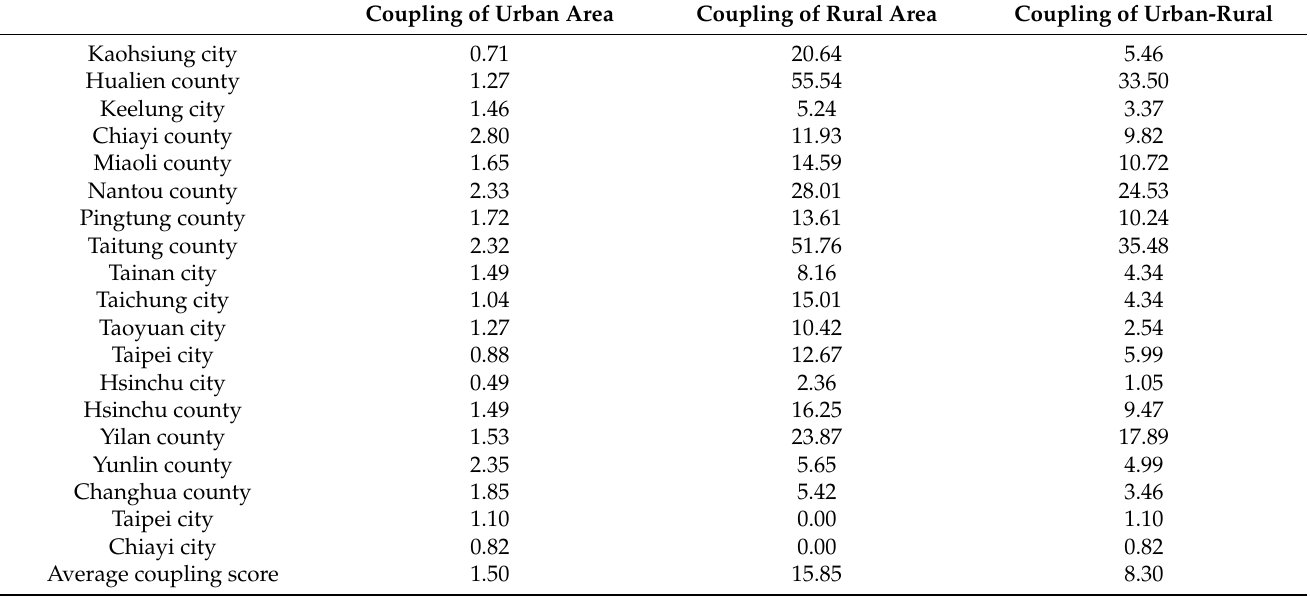
Table 2. Coupling between urban and rural land use. Coupling of Urban Area Coupling of Rural Area Coupling of